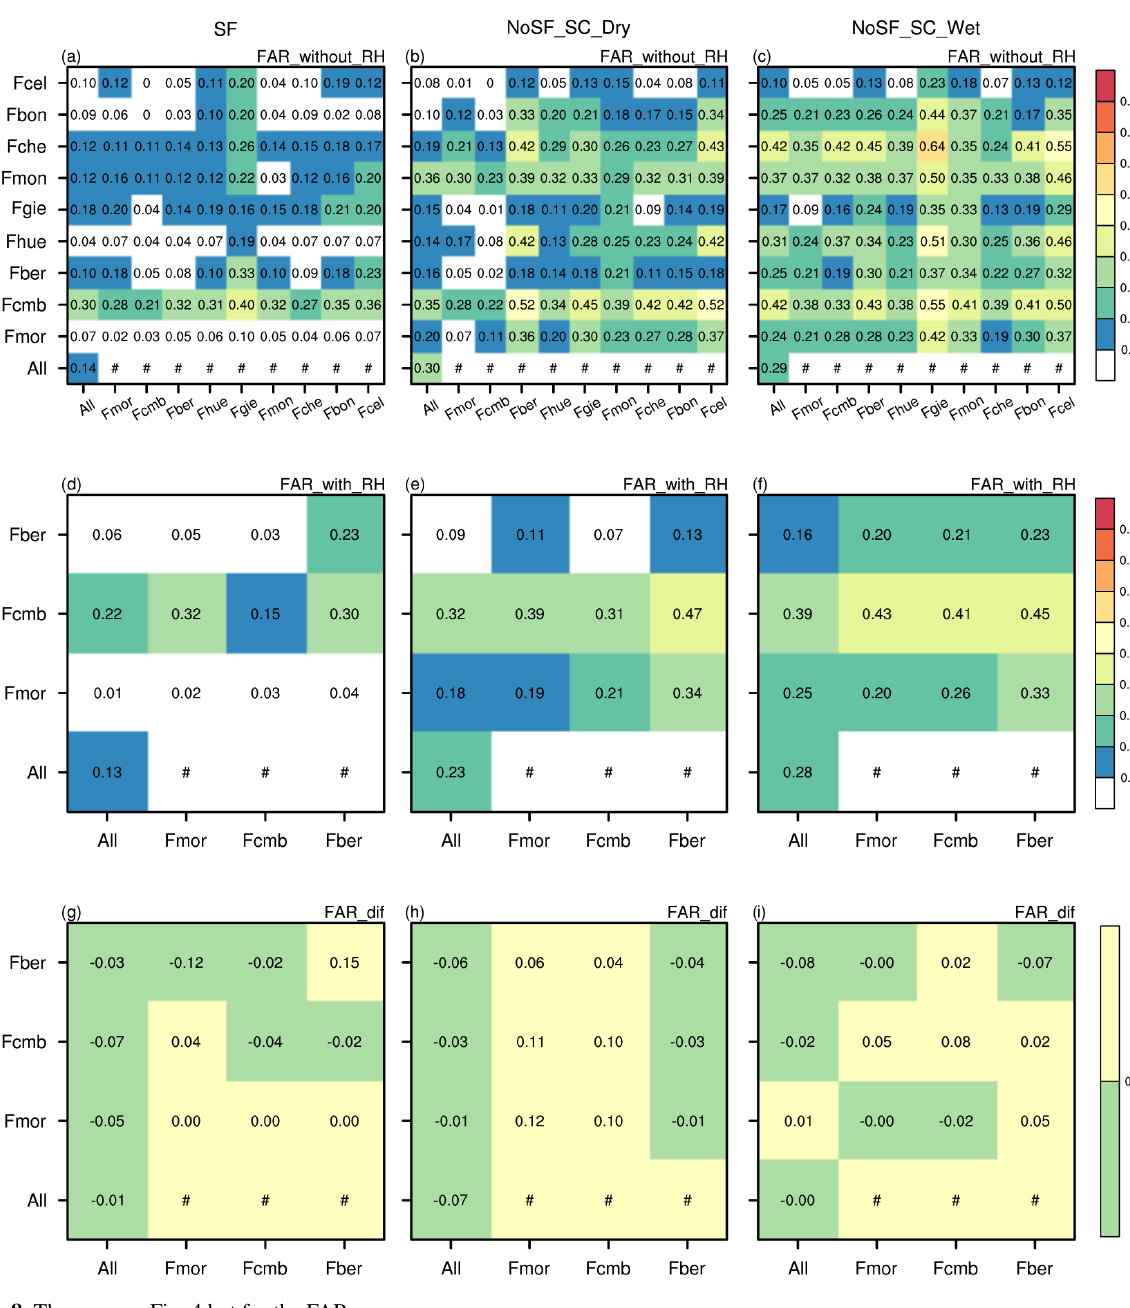
Figure 8. The same as Fig. 4 but for the